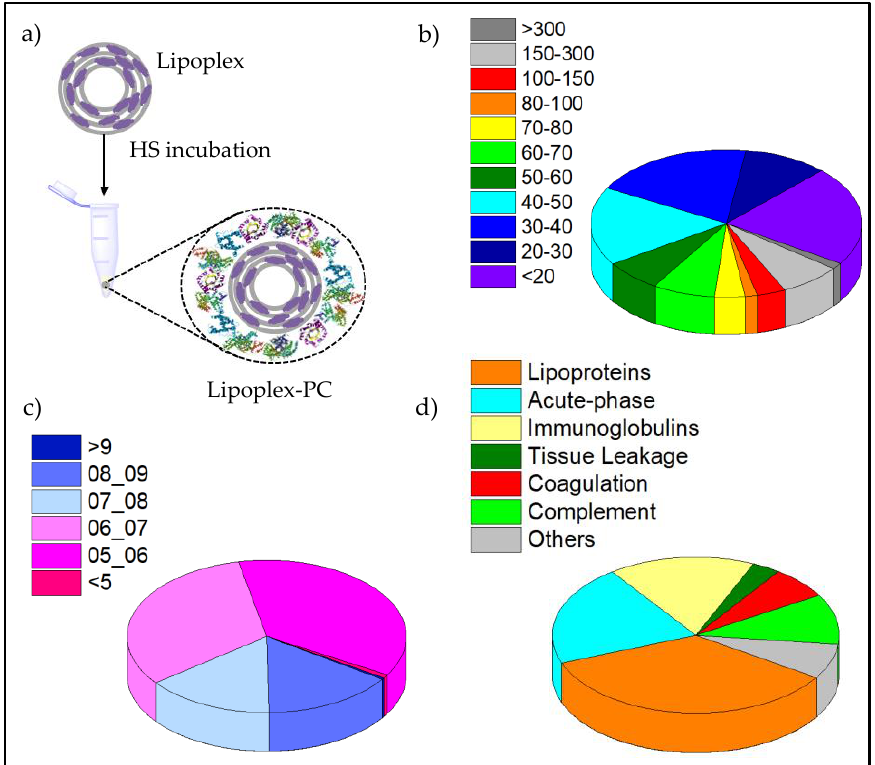
Figure 6. ( a ) Scheme depicting protein corona formation (PC). Percentage of the proteins found within the protein corona (PC) of C 3 (C 16 His) 2 /MOG-siRNA lipoplexes at α = 0.2 and ρ eff = 10, classified by their molecular weight, MW in kDa (pie chart b ), by their isoelectrical point, pI (pie chart c ) and by their physiological function (pie chart d ).